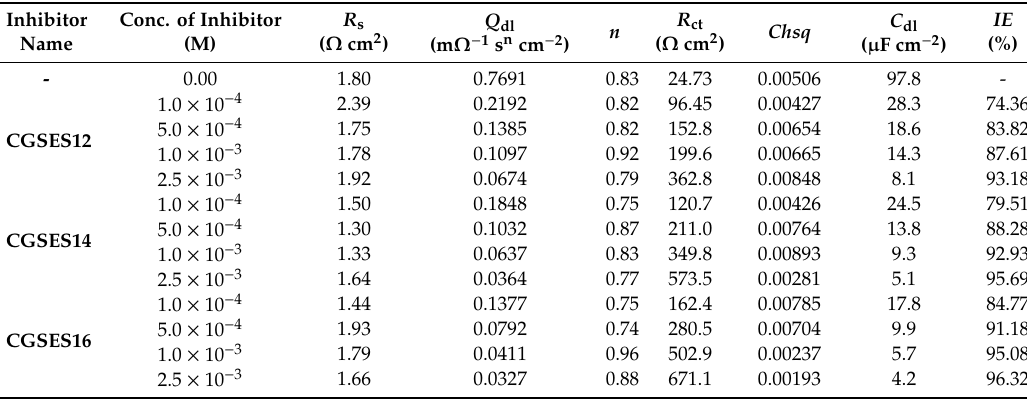
Table 5. Electrochemical impedance parameters for CS in 1 M HCl with and without different concentrations of the synthesized cationic gemini surfactants at 20 °C.